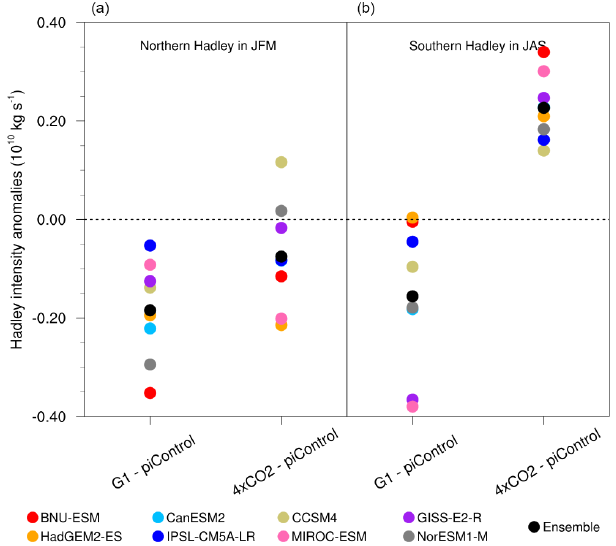
Figure 8. Anomalies (10 10 kgs − 1 ) relative to piControl amongst models in Hadley circulation for the northern cell in JFM (a) , de- fined as the magnitude of the mean meridional stream function be- tween 15 ◦ S and 40 ◦ N, and (b) the southern cell in JAS, defined as the magnitude of the mean meridional stream function between 15 ◦ N and 40 ◦ S. The dot size for the models is about 1 standard error of the model